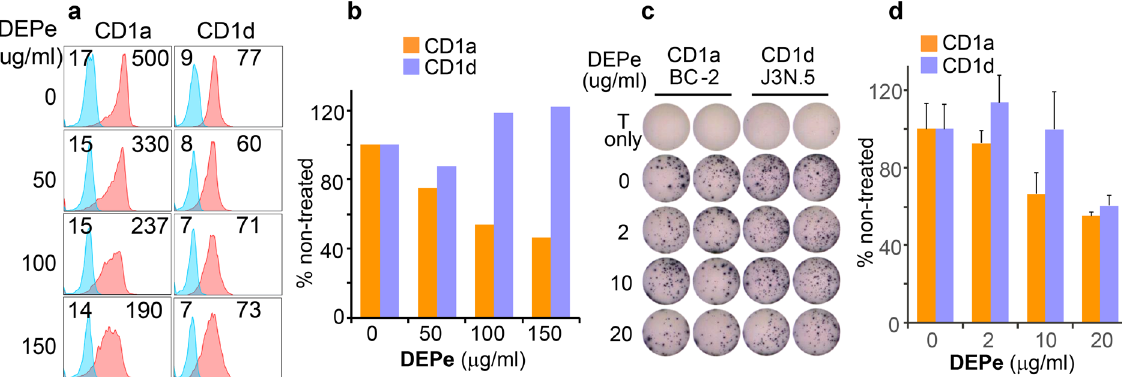
Figure 2. Inhibition of CD1a expression and T cell activation by DEPs. Expression of CD1a and CD1d proteins on DEP-exposed DCs and T cells responding to DEP-exposed DCs were similarly tested and shown as in Fig. 1. Mean fluorescence intensity (MFI) of CD1 staining was labeled by the histogram ( a ) and was also normalized to that of non-stained samples ( b ). T cell activation mediated by DEP-exposed DCs was tested by IFN- γ production and shown with an immunospot assay ( d ). Quantified immunospot results show certain inhibitory effect of DEP on the activation of CD1a-restricted BC-2 cells in a dose-dependent manner ( e ). Standard errors from technical replicates of each sample are shown. Data are from one experiment using cells from an independent donor. Two experiments were performed with similar